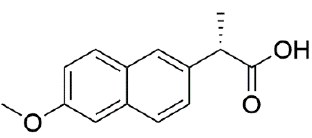
Figure 1. Naproxen model compound used in nanosuspensions formulations.